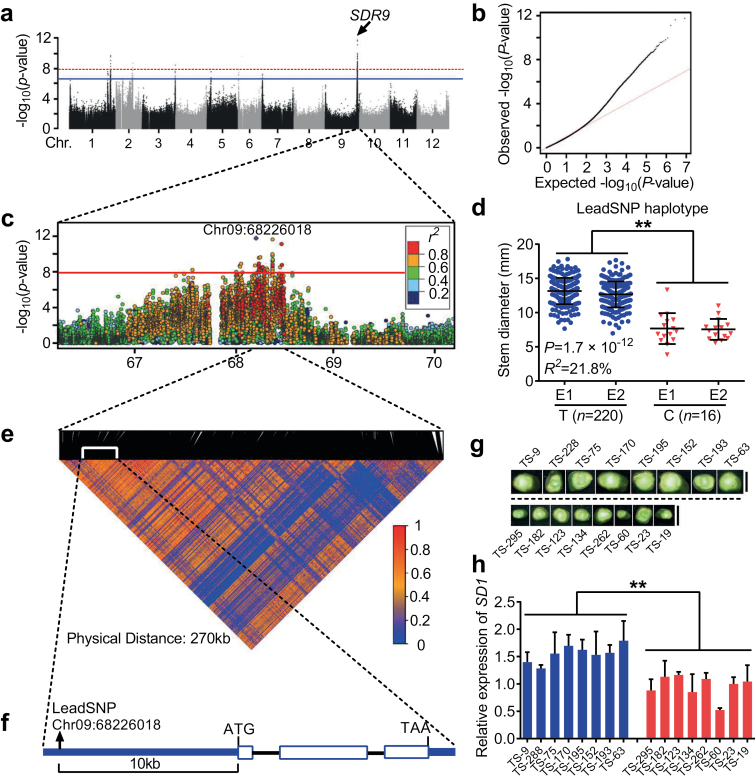
Genome-wide association study of the stem diameter (SD) trait in environment 1. (A) Manhattan plot displaying the genome-wide association signals for SD in the tomato genome (n=270) using the compressed MLM model. The y-axis indicates –log10 transformed observed P-values. The blue and red horizontal dashed lines indicate a genome-wide suggestive (2.4×10–7) and significant (1.2×10–8) threshold, respectively. The arrow indicates the most significant signal (SDR9) on chromosome 9. (B) Quantile-quantile plot for SD in the GWAS population. (C) Genome-wide association signal for the SD is shown on the 66.2–70.2 Mb region (x-axis) of chromosome 9. The lead SNP is indicated in purple and the colour of each plot corresponds to the r2 value (a measure of LD) according to the legend. (D) Box plot for SD in two genotypes distinguished by the lead SNP Chr09:68226018. (E) Representation of the pairwise r2 values (a measure of LD) among all polymorphic sites in the 270-kb genomic region corresponding to (C). The 145 haploblocks are represented by the inverted triangle. The haploblock contains the lead SNP associated with SD as indicated. (F) Gene structure of SD1 (Solyc09g082510). The blue box, blue lines and black lines represent coding sequence, promoter and 3′-UTR, and introns, respectively. The relative position of the lead SNP to SD1 is indicated. (G, H) SD (G) and the relative expression of the candidate gene (SD1) (H) in the stem apices of 16 selected accessions (eight thin-stem accessions and eight thick-stem accessions). Data represent means ±standard deviation (n=3). Asterisks indicate significant differences by t-test: **P<0.01.